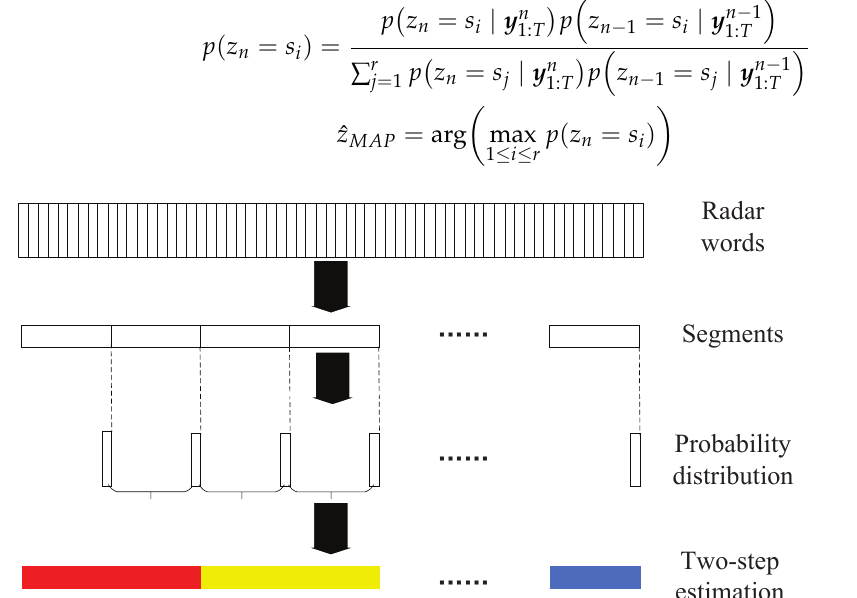
Figure 5. A flowchart of the state